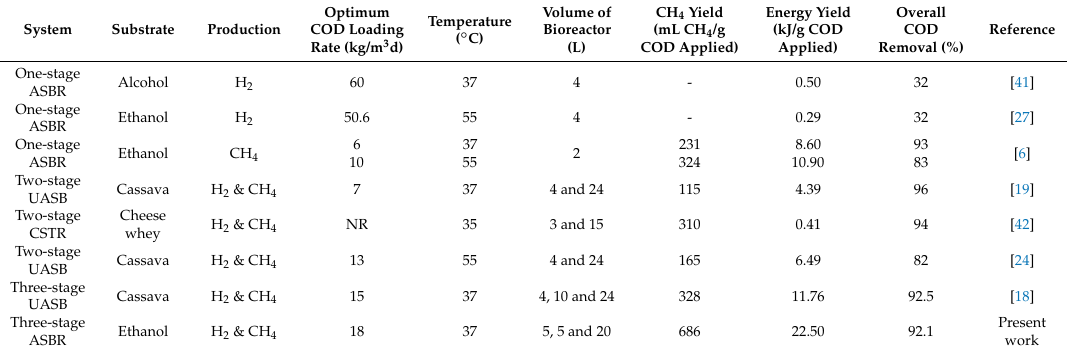
Table 3. Comparison of the three - stage ASBR system with other studies.